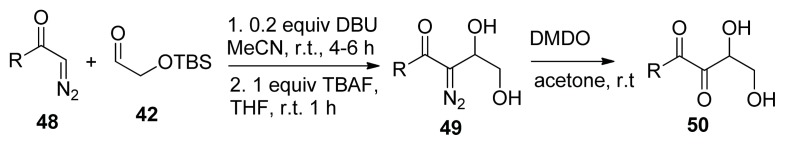
Synthesis of DPD and analogs developed by Sintim and co-workers. DBU = 1,8-diazabicycloundec-7-ene, TBAF = tert-butyl ammonium fluoride, THF = tetrahydrofuran, DMDO = dimethyldioxirane.